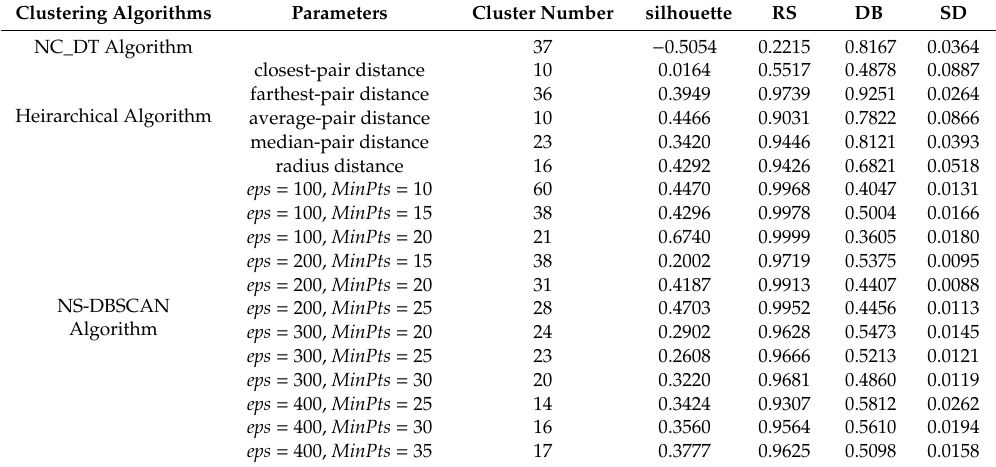
Table 4. Indicators for Evaluating the Effectiveness of Clustering Algorithms.